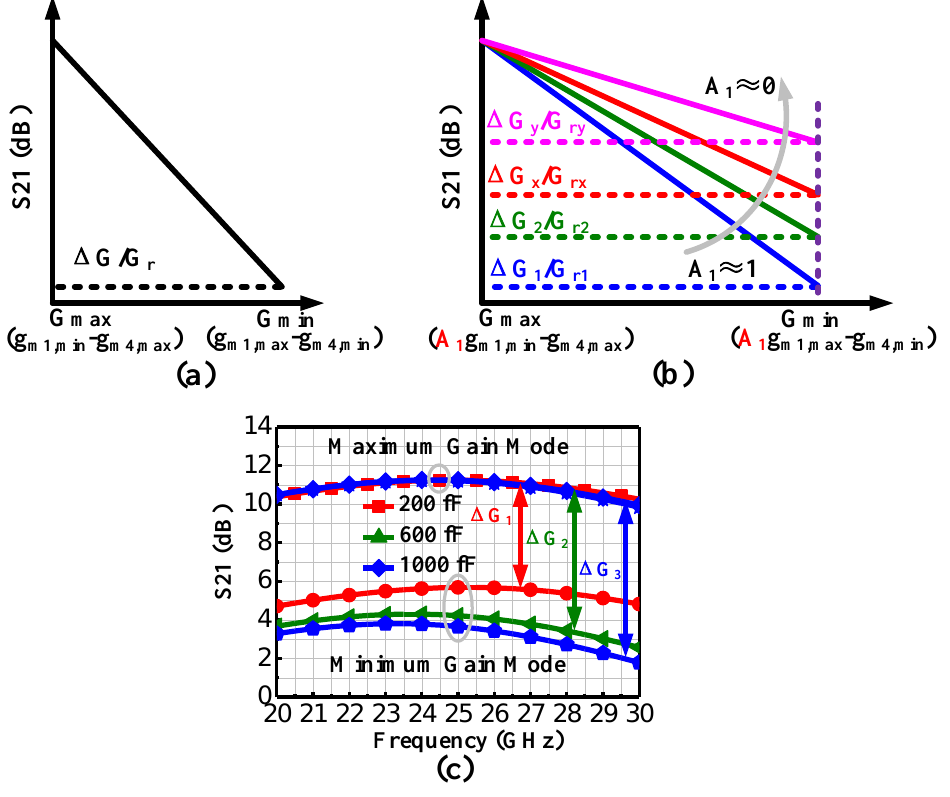
Figure 4. ( a ) Conventional methods to obtain ∆ G max and G r ; ( b ) a new method to configure ∆ G max and G r with proposed asymmetric capacitor-based reconfigurable technique; ( c ) with different values of C x , simulated small-signal gain versus frequency at the maximum and minimum control states.